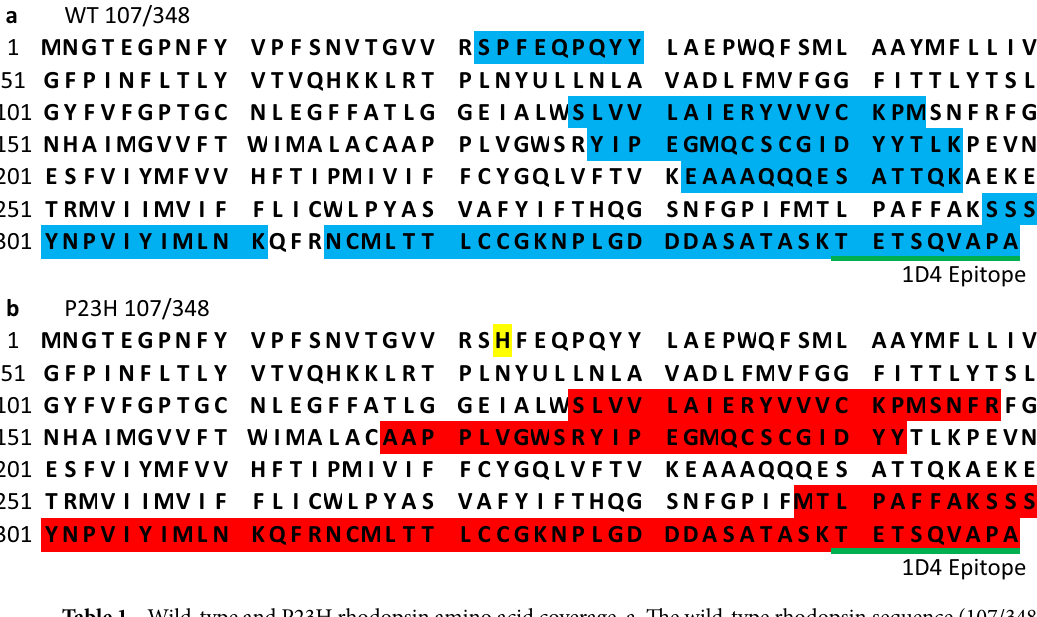
depleted or absent for P23H rhodopsin (Fig. 2a,b). In our MEF interactome control, as expected, no rhodopsin trafficking proteins were found (Fig. 2b). Together, these findings suggested that P23H rhodopsin was unable to traffic properly to the outer segment. These studies are consistent with in vitro studies that show marked reduc- tion of P23H rhodopsin from cell membrane surface and retention in the ER when expressed in HEK293 cells 20 ; and prior Rho P23H/P23H mouse studies that show little rhodopsin in the outer segment 19,45 . Although the P23H rhodopsin interactome was markedly depleted in proteins involved in phototransduc- tion, retinal cycle, and rhodopsin trafficking to the outer segment, we observed significant enrichment in many ubiquitination proteins including polyubiquitin precursor (UBB) 46,47 ; several ubiquitin ligases (TRIM21, NEDD4, HUWE1) 48 ; and ubiquitin-ribosomal fusion proteins (UBA52, RPS27A) 46,47,49 (Fig. 2c). By contrast, none of these ubiquitination proteins, apart from RPS27A, were detected in the wild-type rhodopsin and MEF interactomes (Fig. 2c). Enrichment of ubiquitin in the P23H rhodopsin interactome is consistent with prior studies that found significant ubiquitination of P23H rhodopsin compared to wild-type rhodopsin 19 .